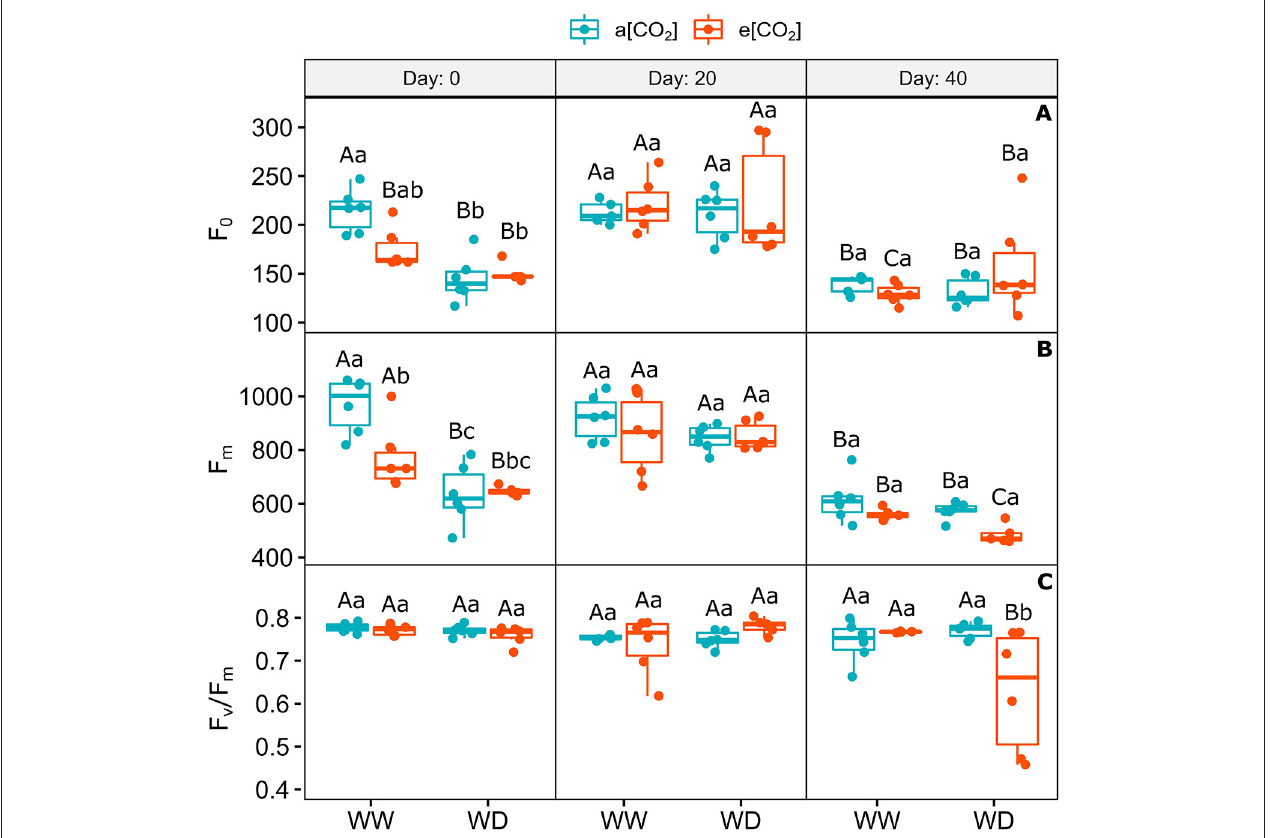
FIGURE 3 | Photochemical parameters of C. arabica plants exposed to ambient [CO 2 ] under well-watered and water deficit (a[CO 2 ] + WW and a[CO 2 ] + WD, respectively) and elevated [CO 2 ] under well-watered and water deficit (e[CO 2 ] + WW and e[CO 2 ] + WD, respectively) conditions on day 0, 20, and 40 after water deficit imposition in the OTC. (A) Chlorophyll a minimum fluorescence, (B) Maximum fluorescence, and (C) Maximum quantum efficiency of PSII. Boxes represent the median and first and third quartiles, symbols represent individual samples ( n = 6–5 biological replicates). Different capital letters represent significant differences between sampling day in the same water and [CO 2 ] condition, whereas different lowercase letters represent significant differences between water and [CO 2 ] conditions in the same sampling day according to Tukey’s test at 5% of probability ( P ≤